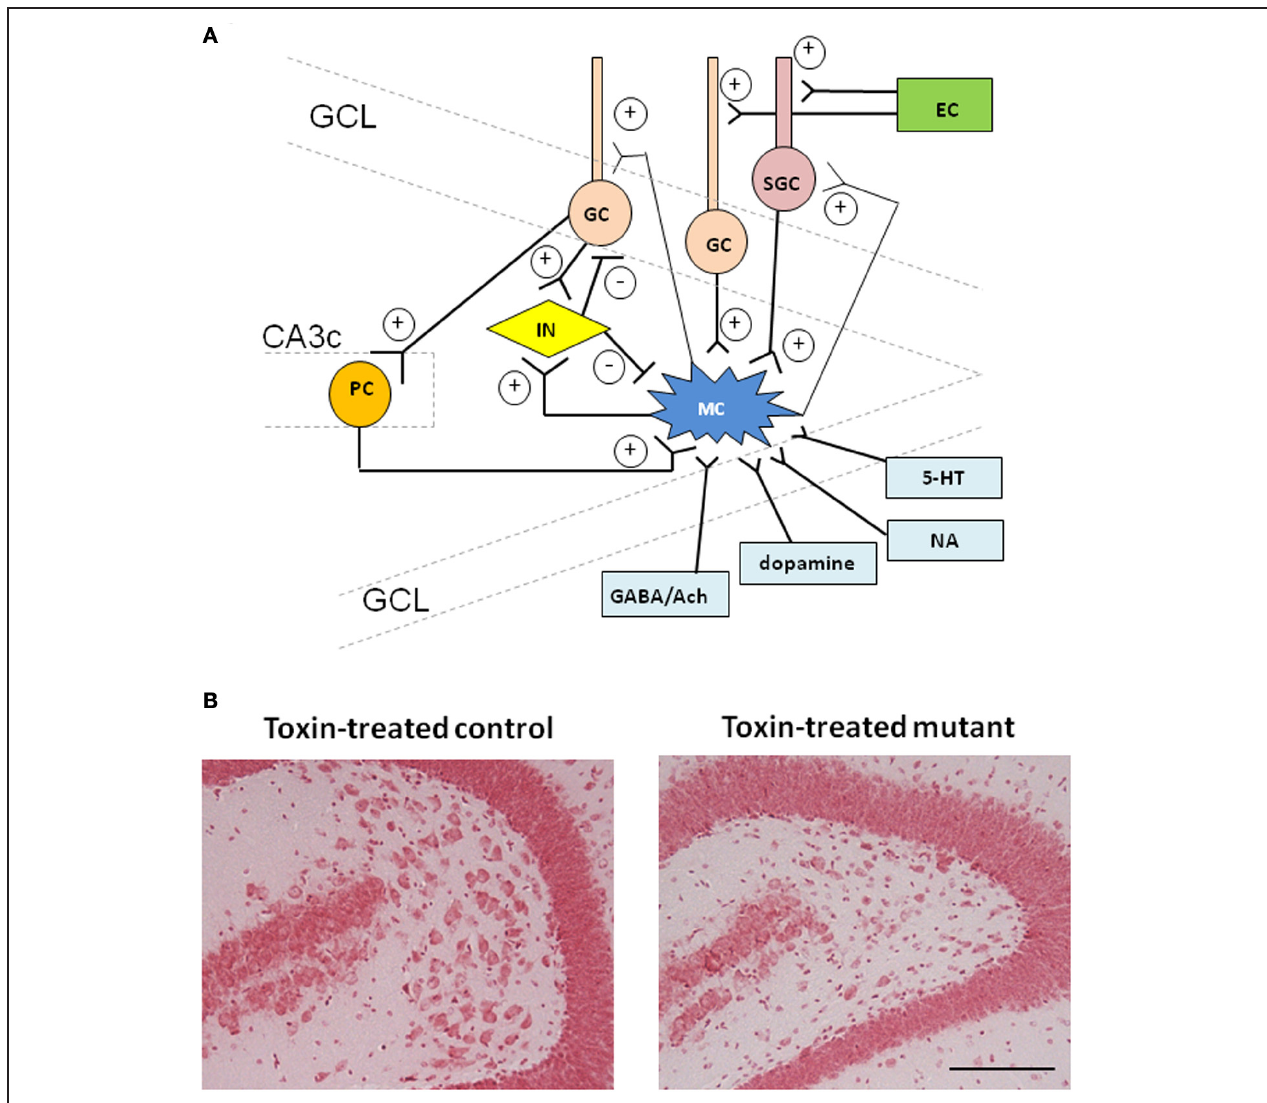
on granule cell proximal dendrites as well as semilunar granule cells. Mossy cells also send axon collaterals to dentate GABAergic interneurons in the different lamellae or in the contra-lateral hippocampus. Mutual connections between mossy cells are rare. For simplicity, not all the connections are shown. Ach, acetylcholine; EC, entorhinal cortex; GC, granule cell; GCL, granule cell layer; IN, interneuron; MC, mossy cell; NA, noradrenaline; PC, pyramidal cell; SGC, semilunar granule cell; 5-HT, serotonin. (B) Representative photographs of Nissl staining showing histological alterations in the hilar region in CA3c/mossy cell-cre/floxed-diphtheria toxin receptor mutant mouse (right) 4 weeks after diphtheria toxin (DT) administration. Compared to DT-treated control (left), mutant mouse showed the decreased cell number in the dentate hilus. Scale bar, 100 μ